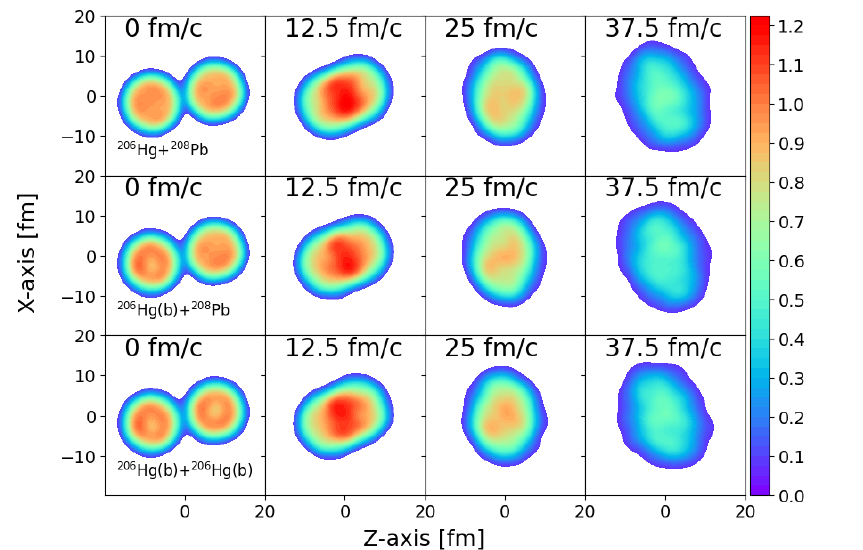
Figure 3. Comparison among the density distribution of three systems in the reaction plane with E beam = 50 A MeV and the impact parameter 3 fm. From top to bottom, the corresponding systems are Hg (nonbubble) + Pb, Hg (bubble) + Pb and Hg (bubble) + Hg (bubble) and “b” in parenthesis is the abbreviation of bubble.